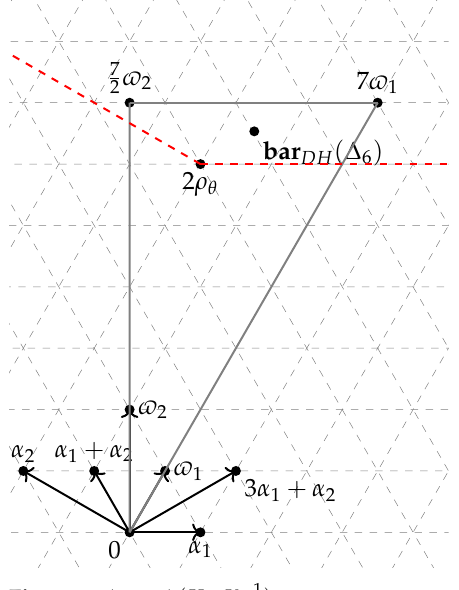
Figure 6. ∆ 6 = ∆ ( X 6 , K − 1